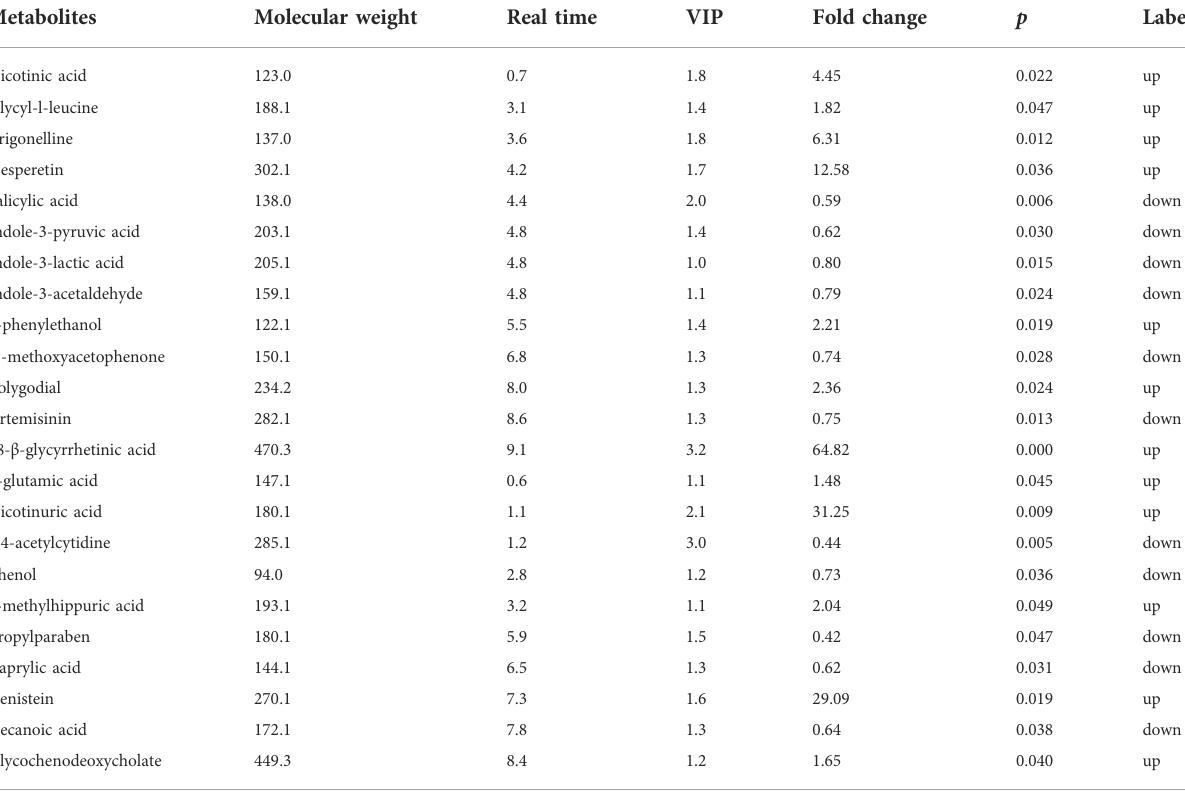
TABLE 2 Identi fi ed differential plasma metabolites between the two groups. Metabolites